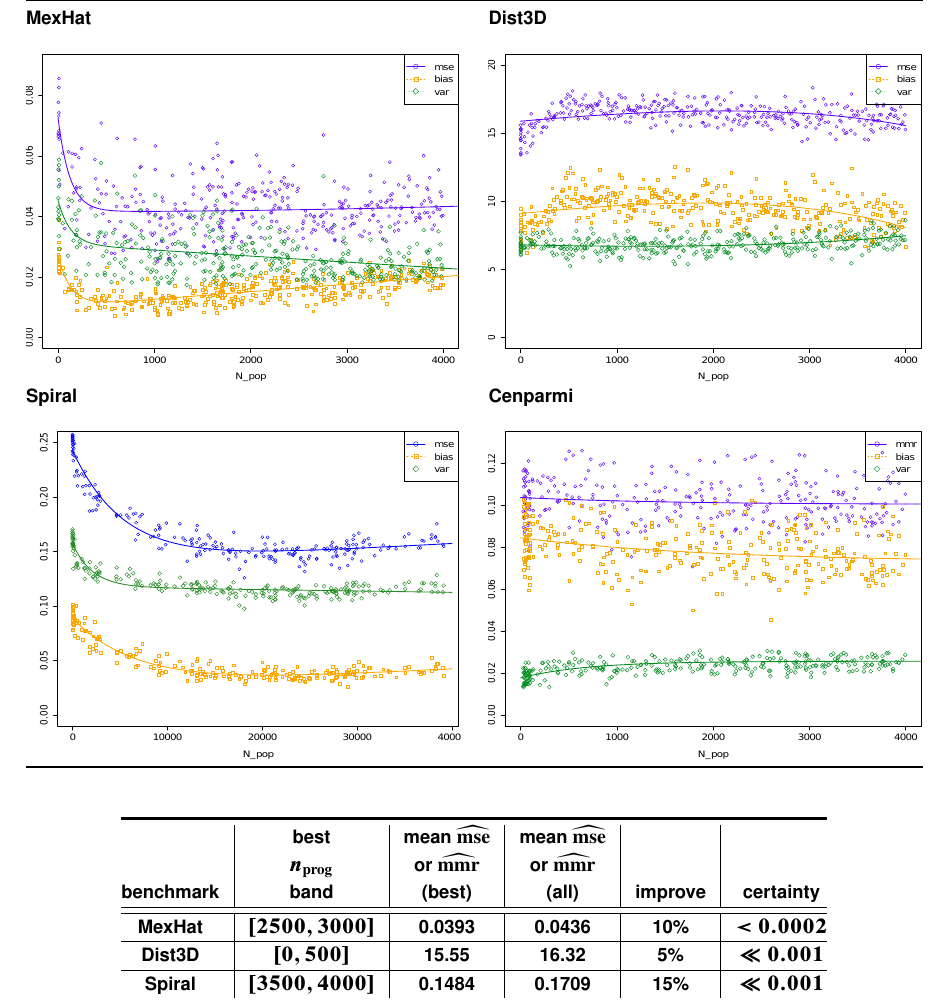
Fig. 6. Best-fit curves, varying over N pop